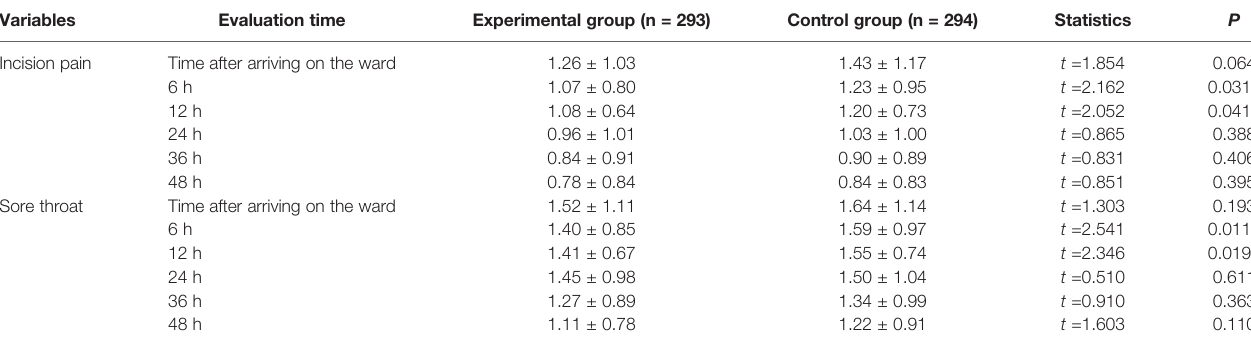
TABLE 2 | Comparison of pain scores between the two groups.